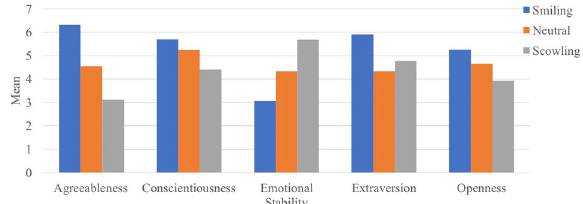
Fig. 8 Big- fi ve personality traits. Means of the Big- fi ve personality traits (Agreeableness, Conscientiousness, Emotional Stability, Extraversion, and Openness) for the smiling, neutral, and scowling facial expressions, age, and gender